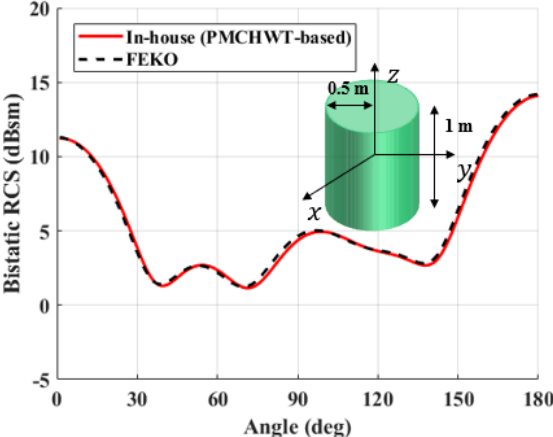
Figure 6. Bistatic RCS of a dielectric cylinder with radius of 0.5 m and height of 1